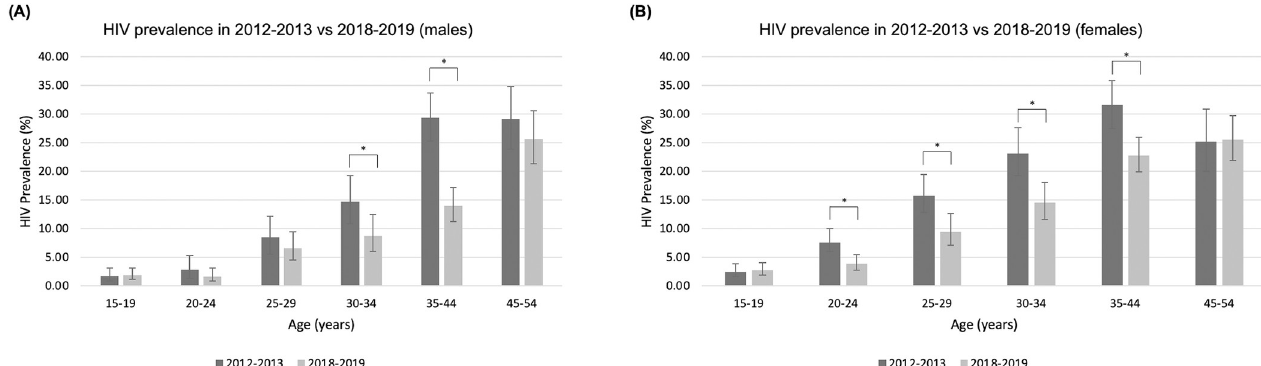
Fig 3. Comparison of HIV prevalence between 2012–2013 and 2018–2019 in overlapping age-groups and study sites. Error bars represent 95% CI. Asterisks ( � ) indicate differences that are statistically significant at the level of p <